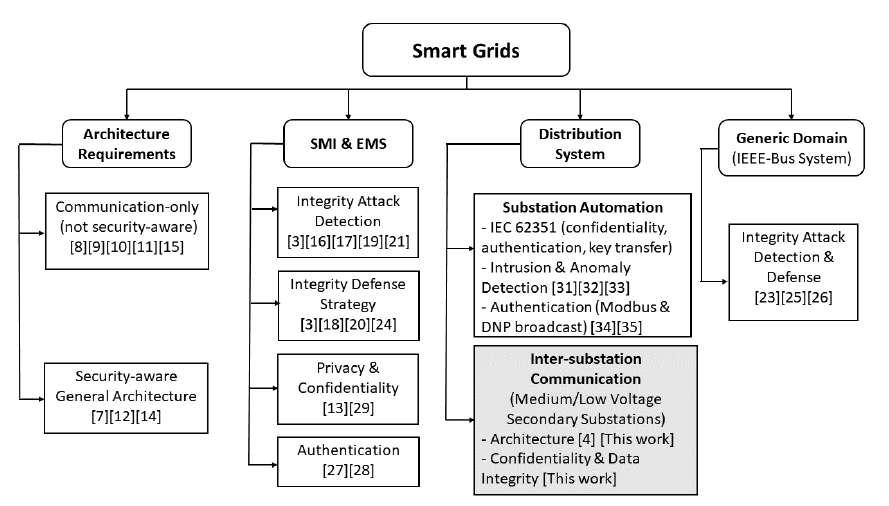
Figure 2. Related works categorized by research